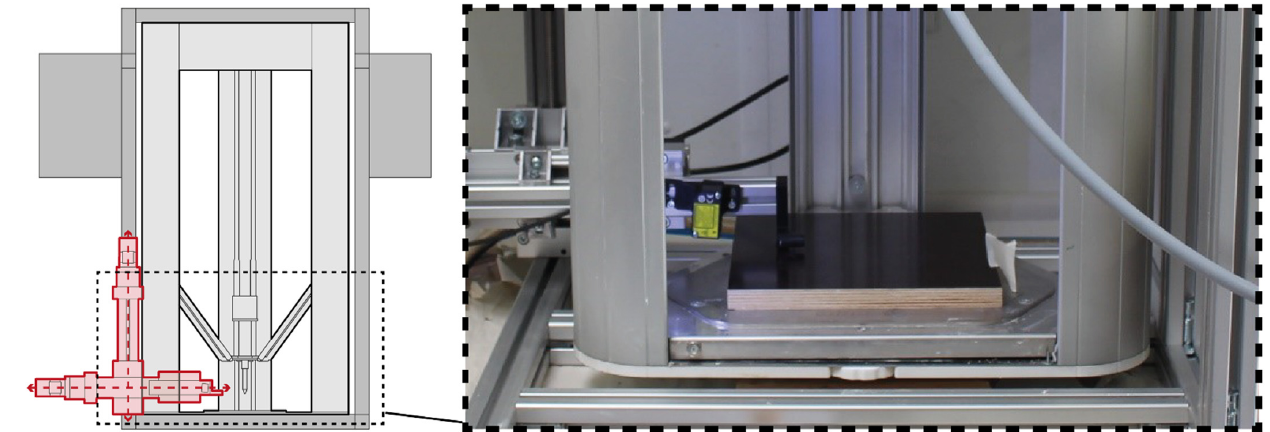
Figure 11. Detail of the structure of the additional module for case study 4.2.